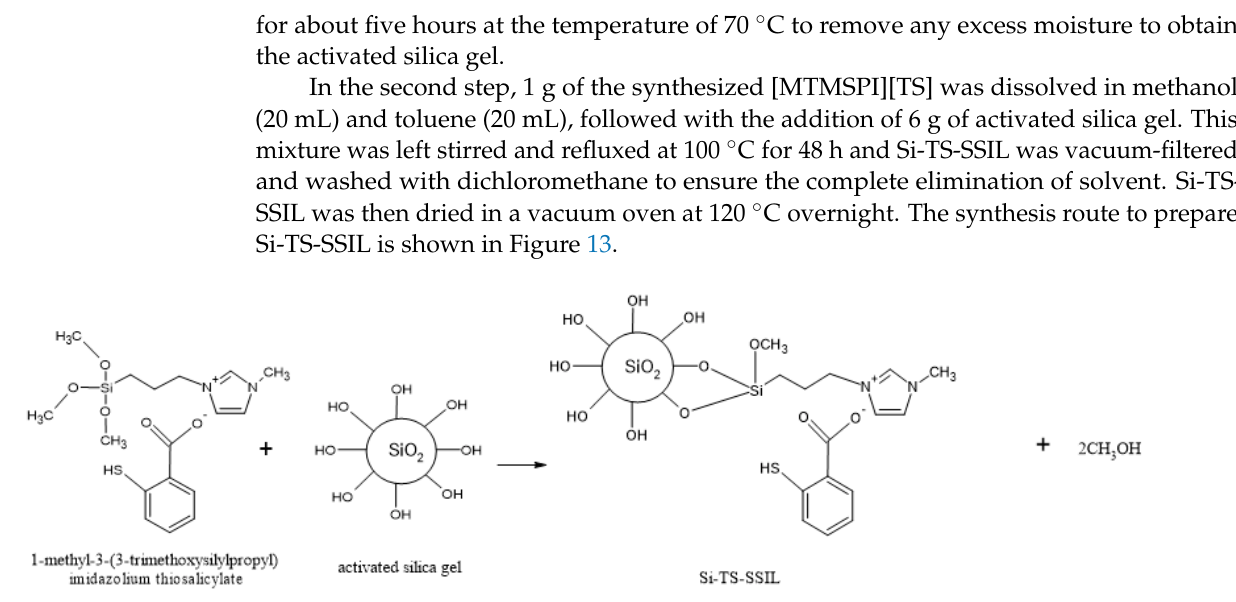
Figure 13. Synthesis route to produce Si-TS-SSIL extractant.